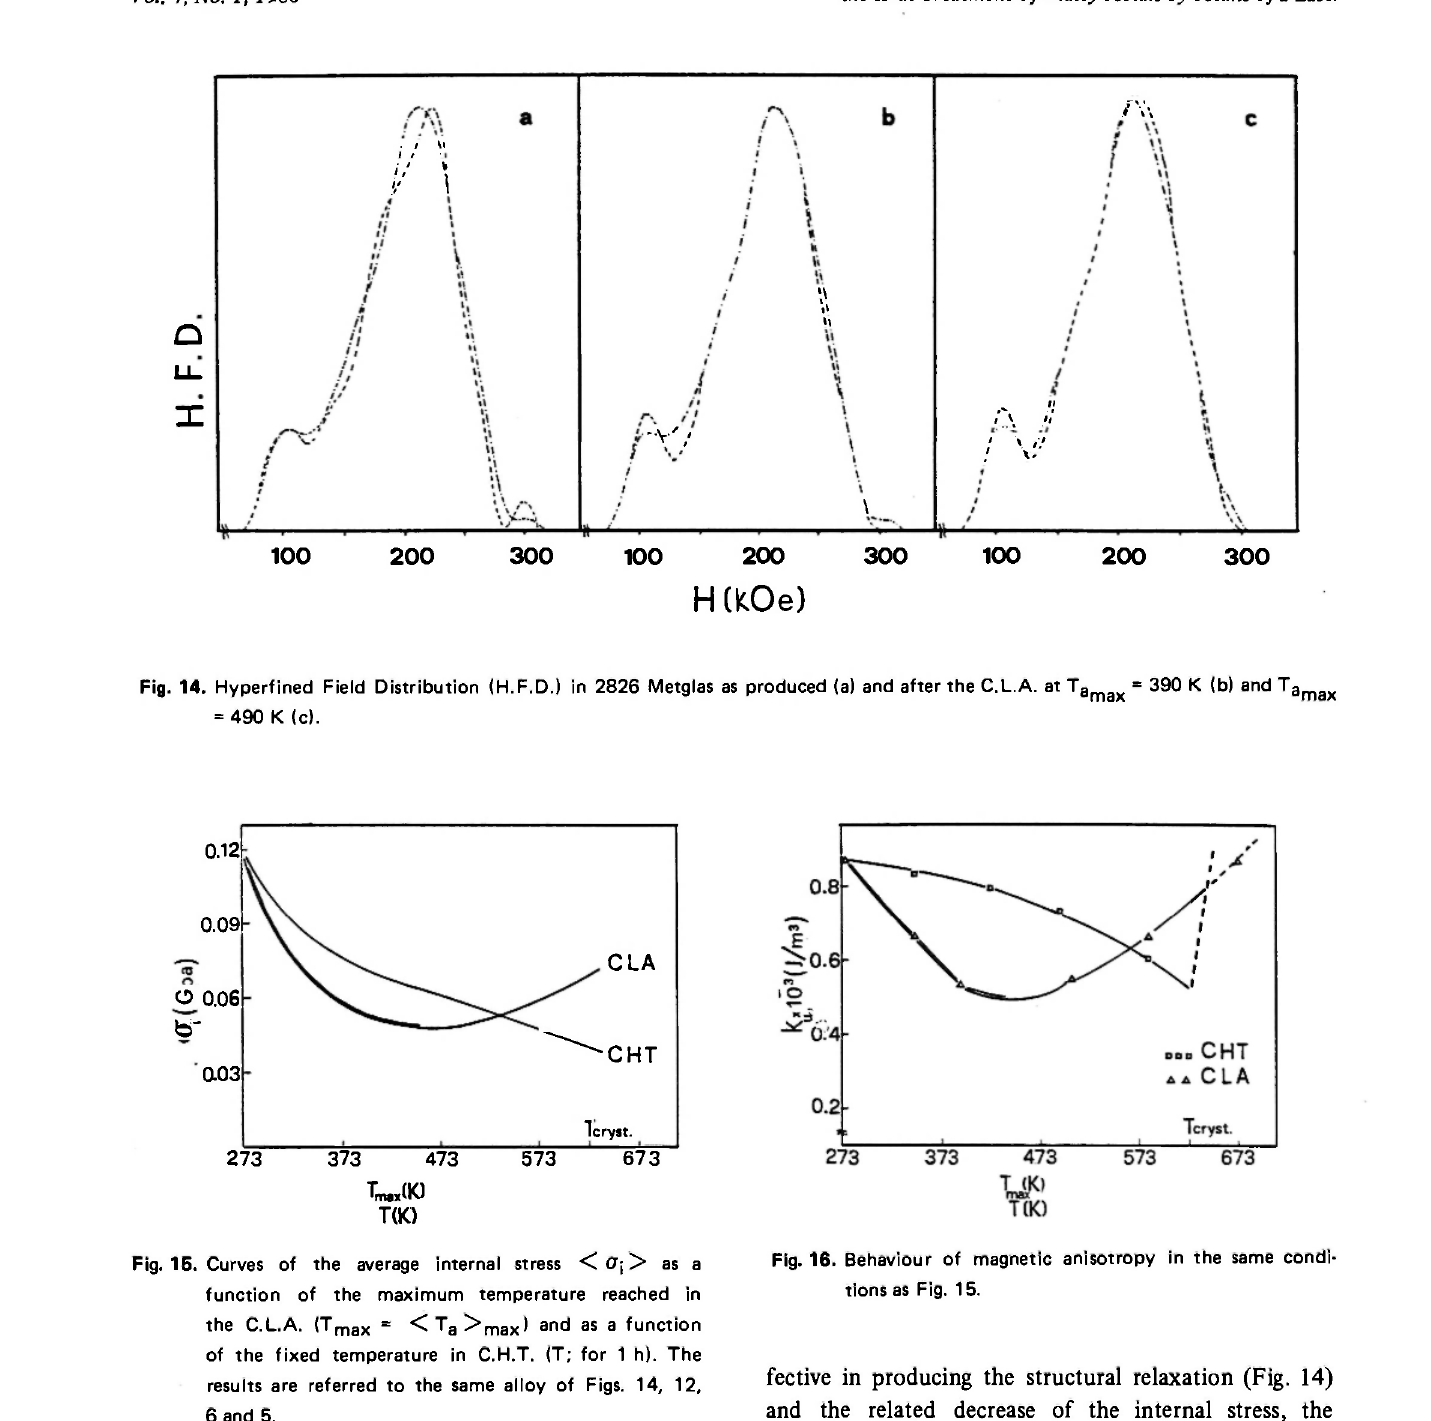
Fig. 16. Behaviour of magnetic anisotropy in the same condi- Fig. 15. Curves of the average internal stress < ( 7 j> as a tions as Fig. function of the maximum temperature reached in the C.L.A. (T max = < T a > max' anc ^ a function of the fixed temperature in C.H.T. (T; for 1 h). The results are referred to the same alloy of Figs. 14, 12, 6 and 5.